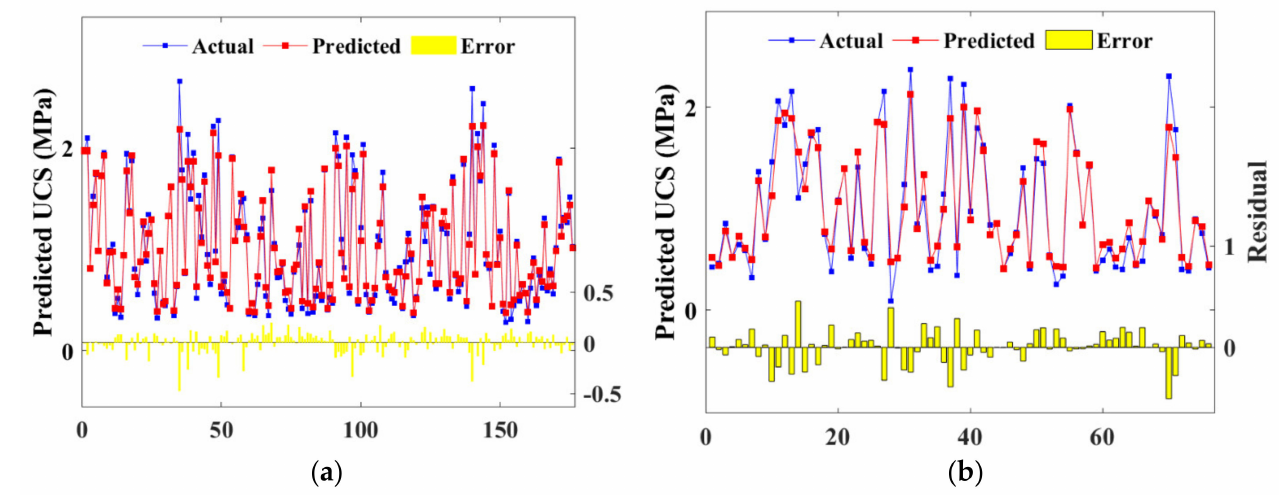
Figure 15. Scatter plot of predicted and actual UCS of RF model: ( a ) training set; ( b ) test set.